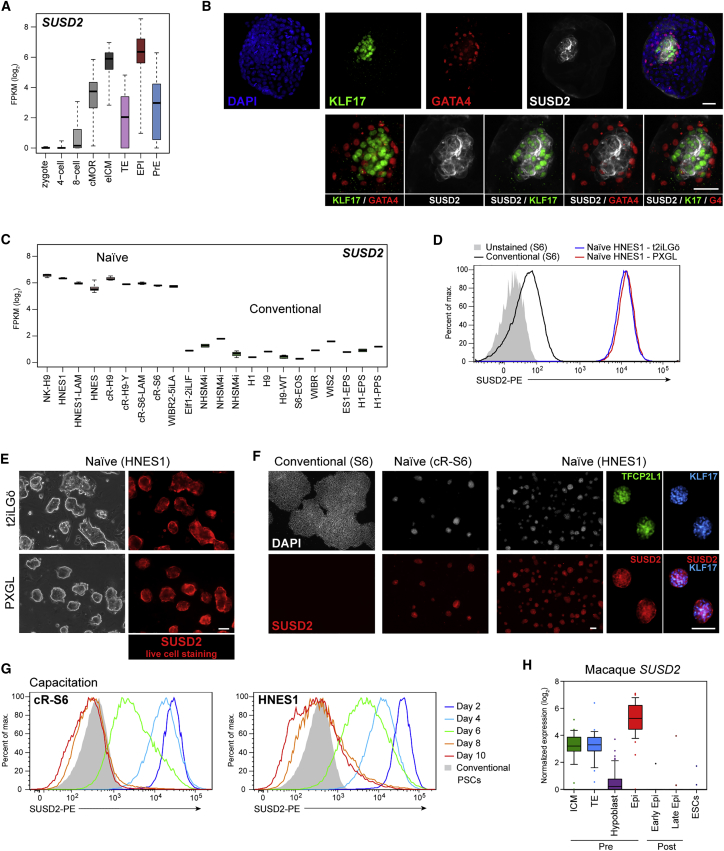
SUSD2 Is Expressed by Human Naive Pluripotent Cells in the Embryo and in Culture(A) SUSD2 transcript levels in human pre-implantation embryos at different stages and lineages, extracted from integrated single-cell RNA-sequencing data (Stirparo et al., 2018).(B) Immunostaining for KLF17, GATA4, and SUSD2 in the E7 human blastocyst. Scale bars, 50 μm.(C) SUSD2 transcript levels in naive and conventional hPSCs (Stirparo et al., 2018).(D) Flow-cytometry analysis of SUSD2 in conventional and naive cells.(E) Images of bright-field and SUSD2 immunostaining using a SUSD2-PE antibody. Scale bar, 50 μm.(F) Immunostaining for SUSD2, TFCP2L1, and KLF17 in conventional and naive (cR-S6 and HNES1) cells. Scale bars, 100 μm.(G) Flow-cytometry analysis of SUSD2 expression during capacitation of cR-S6 and HNES1 cells.(H) SUSD2 transcript levels in Macaca fascicularis embryos (Nakamura et al., 2016). cMOR, compacted morula; eICM, early inner cell mass; TE, trophectoderm; Epi, epiblast; PrE, primitive endoderm.See also Figures S1–S3.